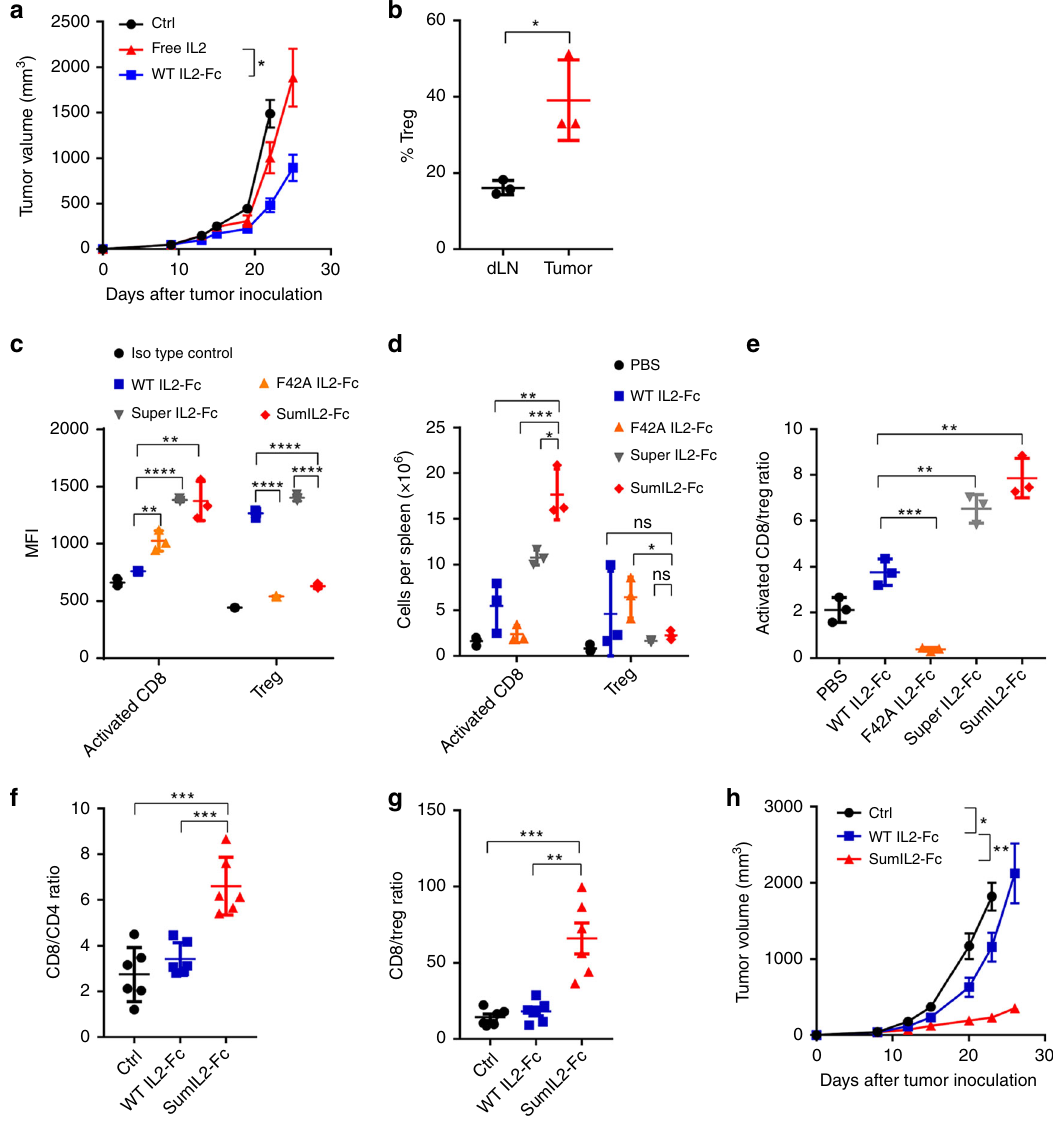
Fig. 1 IL-2 therapeutic effect is limited by binding to Treg preferentially. a WT C57BL/6 mice ( n = 5/group) were injected subcutaneously with 5 × 10 5 B16F10 tumor cells and intratumorally (i.t.) treated with 5 μ g of WT IL-2-Fc or same mole number of free IL-2 on day 9, 13, and 15. b WT C57BL/6 mice ( n = 3 – 5/group) were injected subcutaneously with 5 × 10 5 B16F10 cells. The tumor tissues were collected on day 14. The percentages of Treg cells among CD4 + T cells within tumor tissue and draining lymph node were detected by fl ow cytometry. c Foxp3-GFP mice spleen cells were incubated with IL-2 variants-Fc fusion protein, followed by anti-huIgG-PE staining. d , e WT C57BL/6 mice ( n = 3 – 5/group) were injected intraperitoneally (i.p.) daily with either phosphate-buffered saline (PBS, as a control), 2 μ g WT IL2-Fc, F42A IL2-Fc, super IL2-Fc, or sumIL2-Fc respectively for 5 days. Total cell counts